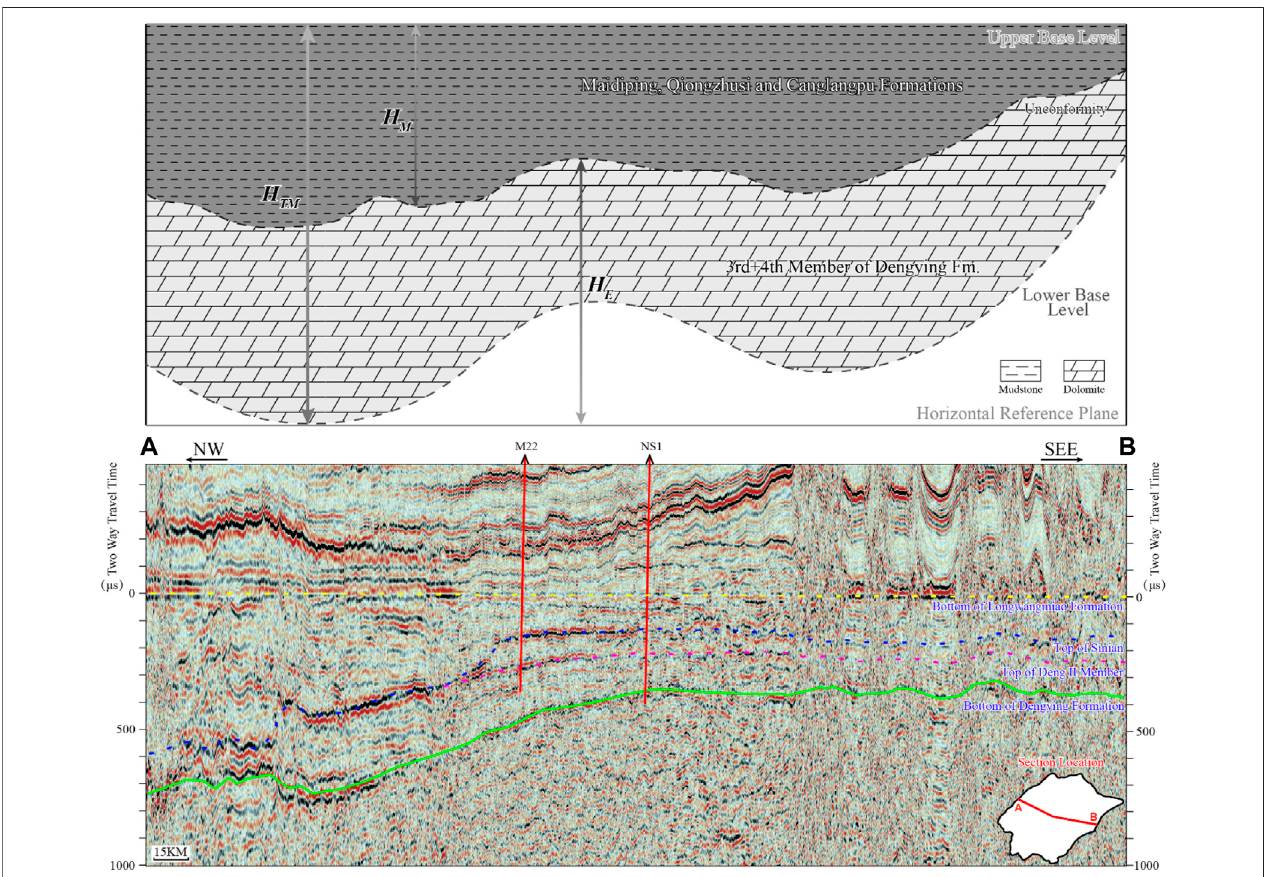
FIGURE 2 | (A) principle of paleogeomorphological reconstruction via the elevation method (modi fi ed from Yan et al. (2016) and Zhao et al. (2018)); (B) seismic re fl ection pro fi le of the upper and lower base levels. The bottom of the Є 1 l and the top of the Z 2 dn 2 are optimal as the upper and lower base levels, respectively.